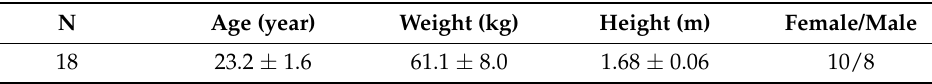
Table 1. Basic characteristics of the